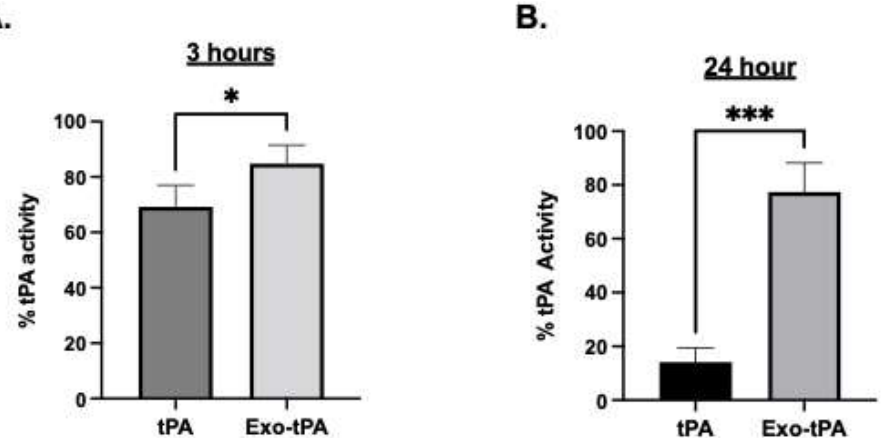
Figure 2. ( A ) Stability of tPA, and exo-tPA after 3 h. ( B ) Stability of tPA, and exo-tPA after 24 h. Stability of the exo-tPA, and tPA was measured using tPA activity assay. n = 3 ± SEM, * p < 0.05, *** p <